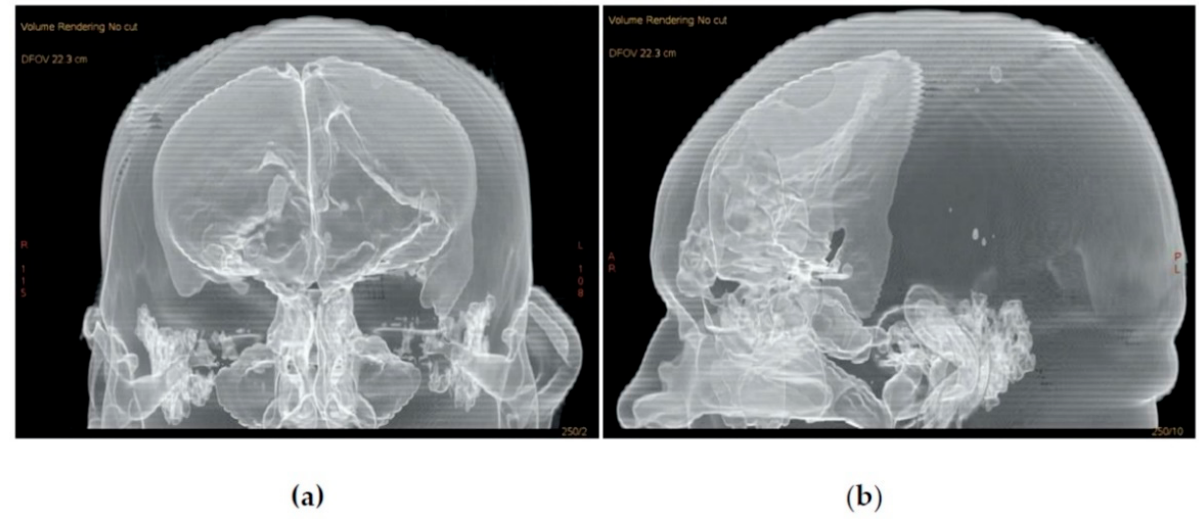
Figure 4. A 3D volume rendering of a CT scan of a patient (no. 6) with tension pneumocephalus. ( a ) Coronal view; ( b ) sagittal view.